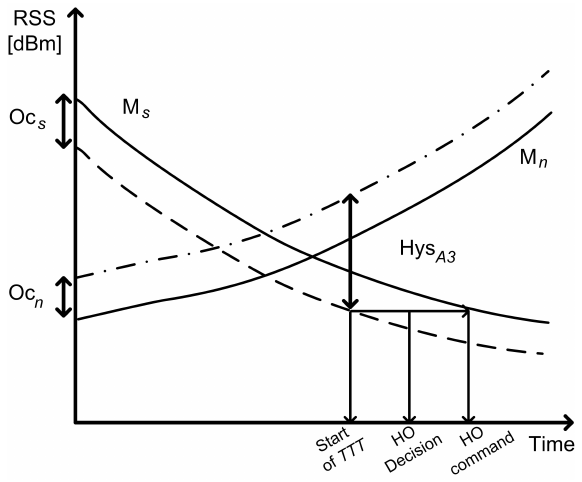
Figure 7. Event A3-based HO parameters in LTE networks.